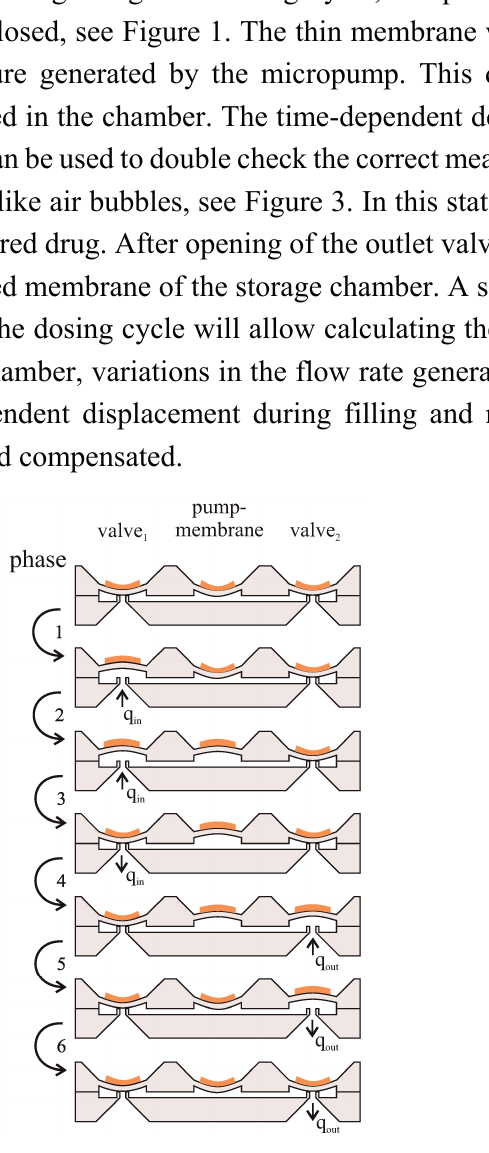
Figure 2. Working principle of the micropump: To create a fluidic flow from the left to the right side the membranes have to be driven in the depicted order. The manufacturing process of the pump can be found in